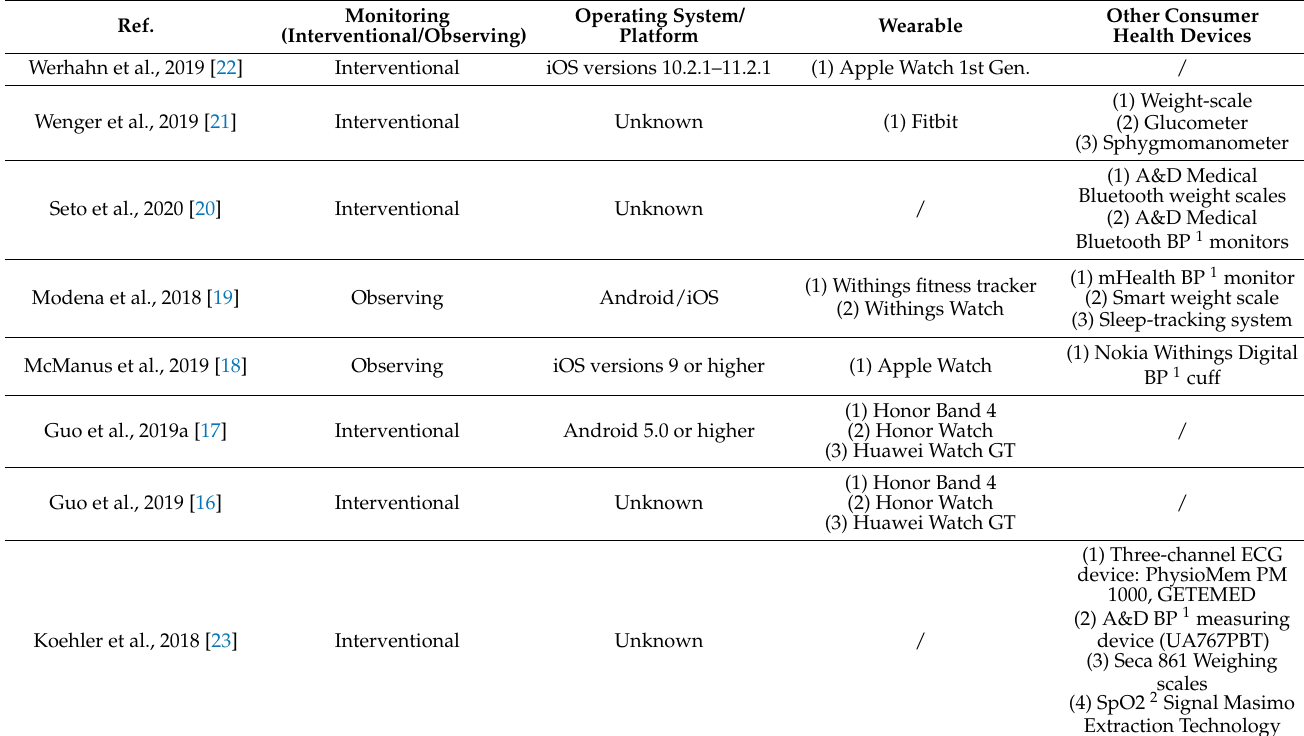
Table 3. Overview of the studies included in the systematic review with a focus on the technical approaches.